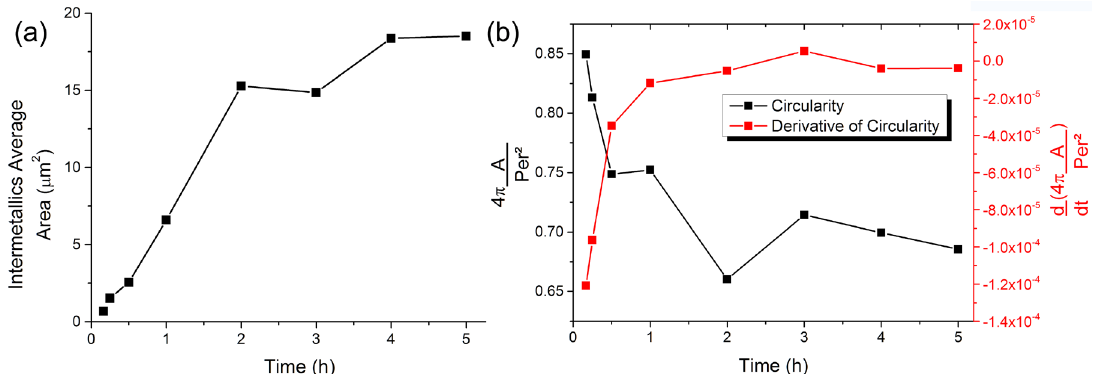
Figure 5. Phase transformations according to time during isothermal heat treatment at 850 ºC. (a) circularity of the intermetallic phase precipitates, (b) mean area of the intermetallic phase